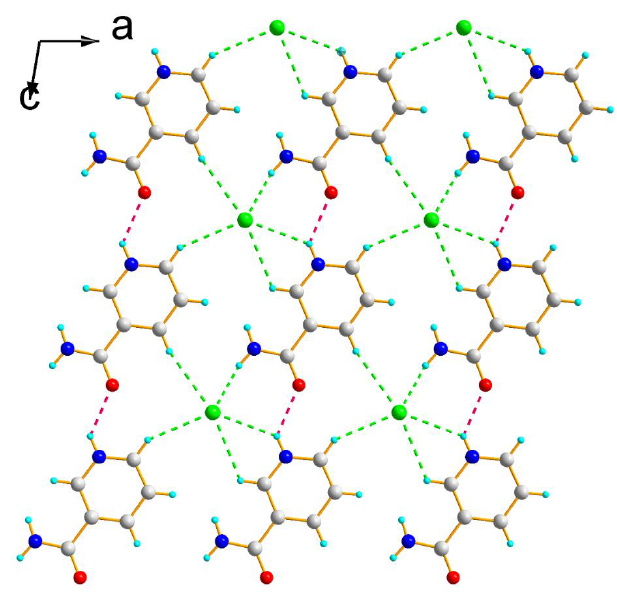
Figure 2. Autostereogram of (C 6 H 7 N 2 O) + ·Cl - showing a 2D-layers stacked along the b -axis.